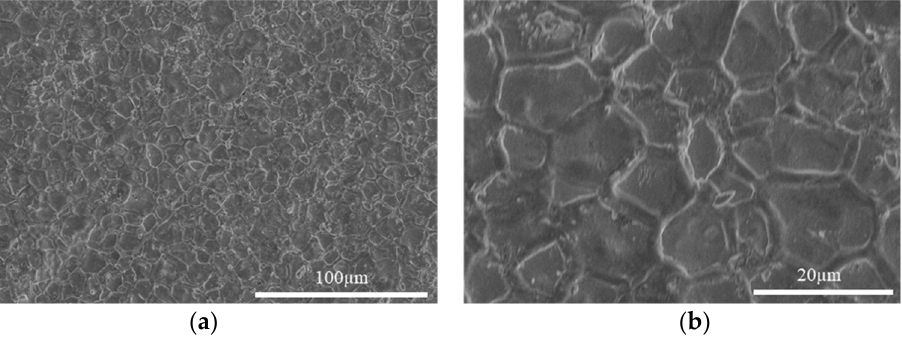
Figure 6. SEM secondary electron images showing the microstructure of as-sintered CeN pellets at